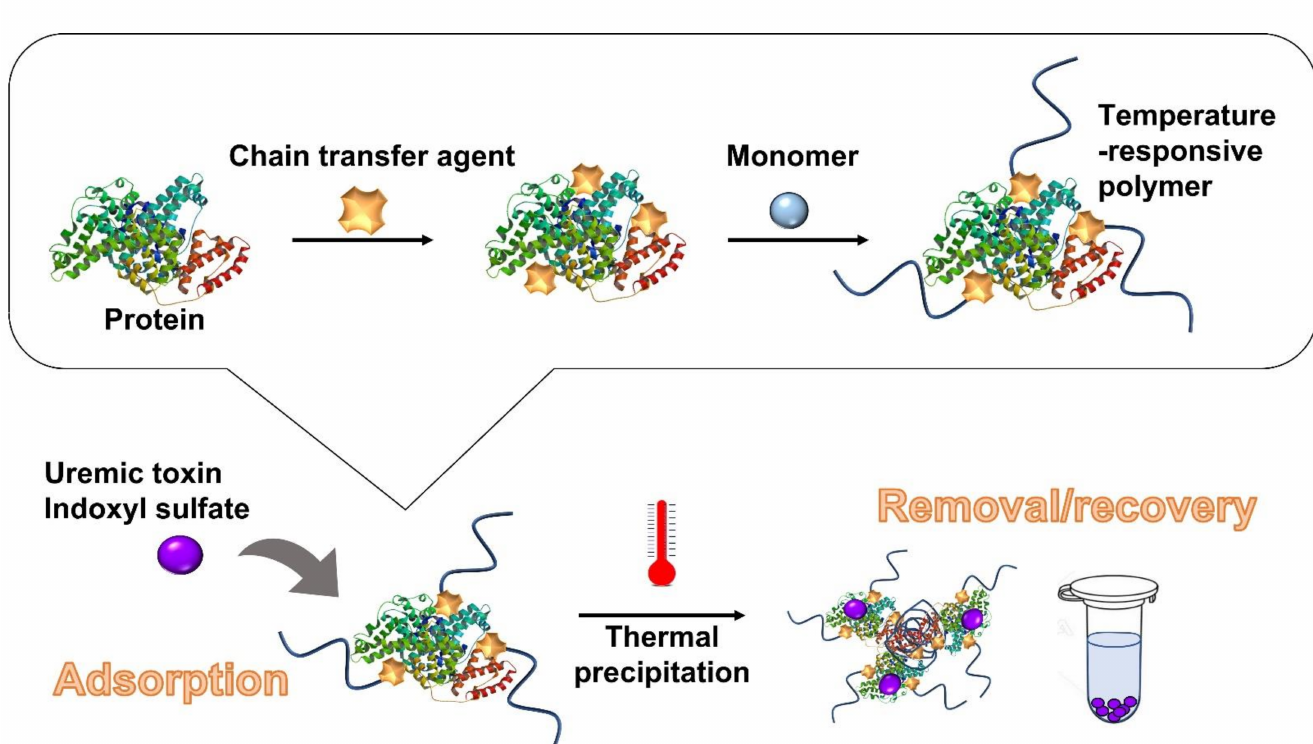
Figure 1. Schematic of the proposed thermally responsive polymer-protein conjugate system. First, protein-PNIPAAm was prepared by “grafting from” method. Next, the conjugate is allowed to capture indoxyl sulfate (IS), one of the uremic toxins. Finally, the captured IS is recovered by thermal